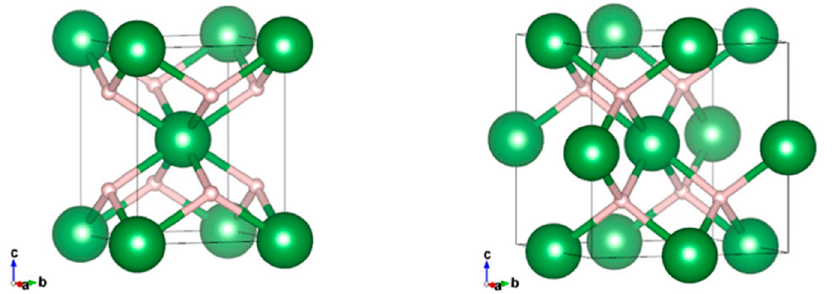
Figure 12. Simulation image of a crystal unit cell for ϵ -ZrH2 ( left ) and δ -ZrH1.5 ( right ). Zirconium atoms are colored green (large), and hydrogen atoms are rose (small). Reprinted with permission from Ref. [111]. Copyright 2021 by the authors and licensee MDPI, Basel, Switzerland.